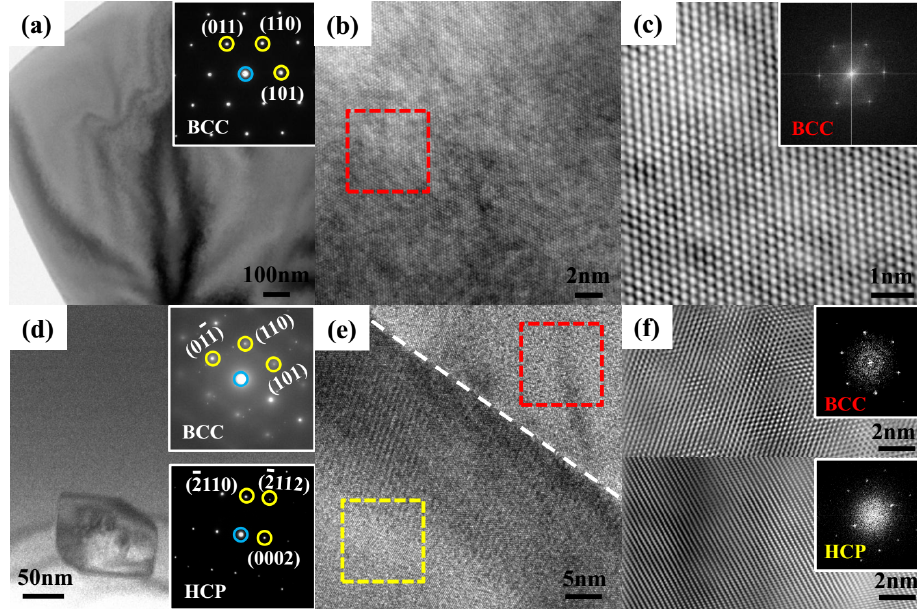
Figure 4. TEM results of as-cast and 1073 K-annealed RHEAs. ( a ) BF image of the as-cast RHEA without tension. The inset is SAED pattern; ( b ) HRTEM image of the as-cast RHEA; ( c ) Fast Fourier transformation (FFT) image of the area covered by red square in ( b ); ( d ) BF image of the hcp precipitate in the 1073 K-annealed RHEA without tension. The inset is the SAED patterns of the matrix and the hcp phase; ( e ) HRTEM image of the matrix and the hcp phase. Red and yellow squares represent the matrix and the hcp phase, respectively; ( f ) FFT images of the areas covered by squares in ( e ).